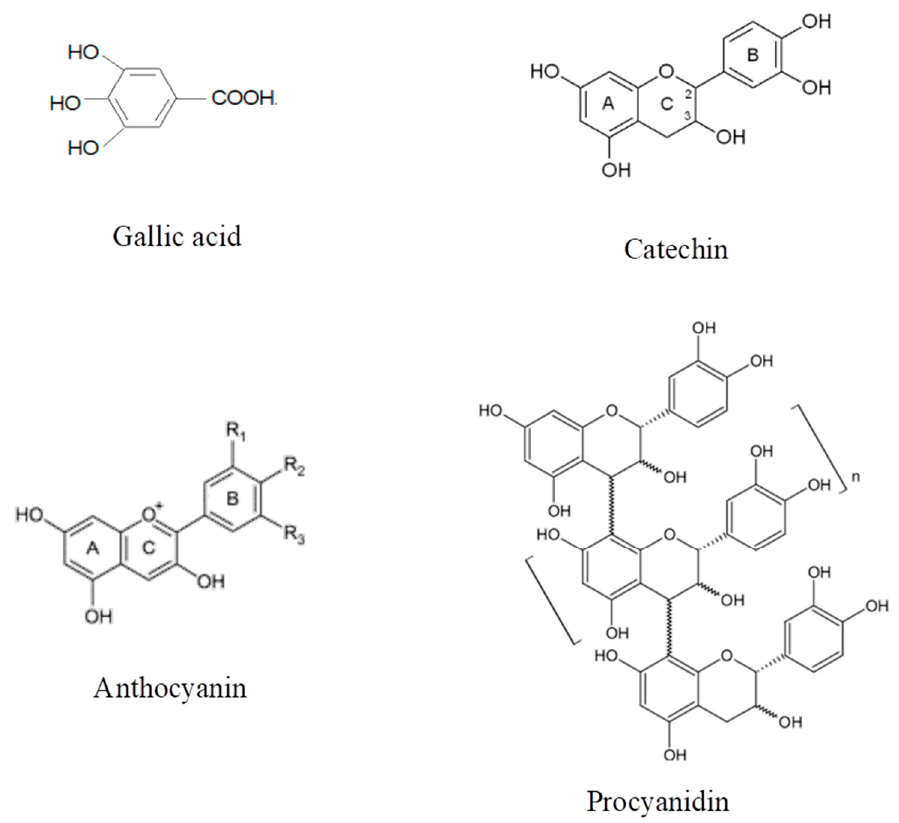
Figure 2. Chemical structure of the phenolic compounds employed in this study. Procyanidins and anthocyanins were the main constituents of the grape seed and red wine extracts, respectively.